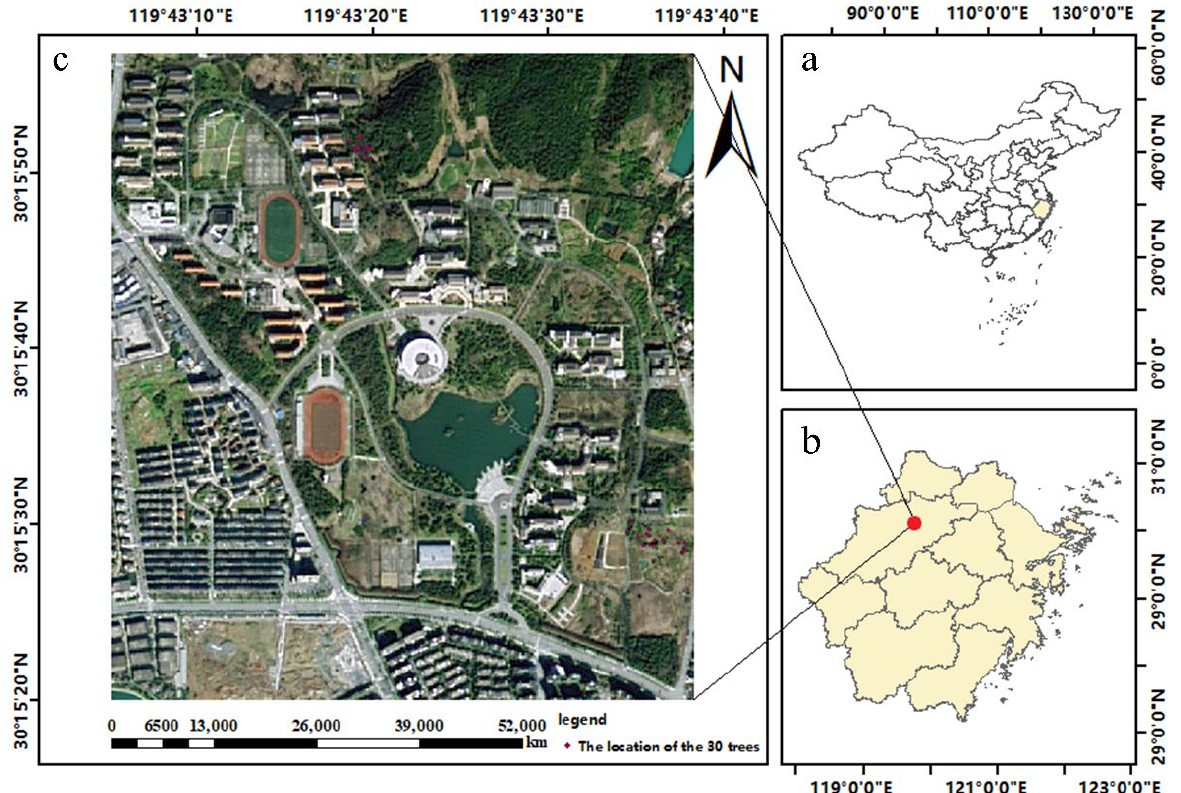
Figure 1. Study area. ( a ) China, ( b ) Zhejiang Province, ( c ) Zhejiang A&F University. The TLS data were measured and pre-processed by Leica ScanStation C5 terrestrial and its accompanying processing software, Cyclone REGISTER360 (Leica Geosystems AG, Heerbrugg, Switzerland). The trunk sample was collected by Swedish hand-held corer CO250 (HAGLOFS, Dalarna, Sweden). Branch and leaf samples were collected by high branch shear. DBH was collected by